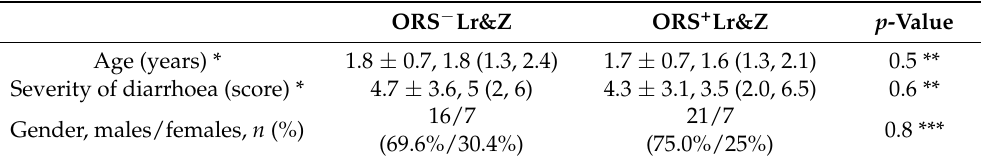
Table 3. Baseline characteristics in the two study